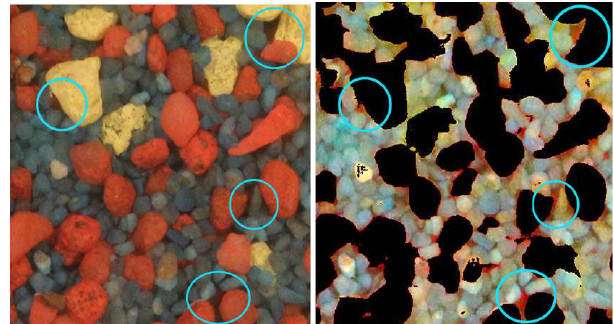
Figure 13. Example of partially buried and therefore shadow-rich red grains, indicated with blue circles, recognized as blue in the colour segmentation; left: original image of a submerged bed sur- face; right: corresponding segmented image for the blue colour. Please note that the blue colour in the segmented image was light- ened to better illustrate the incorrect segmentation of some red grains.